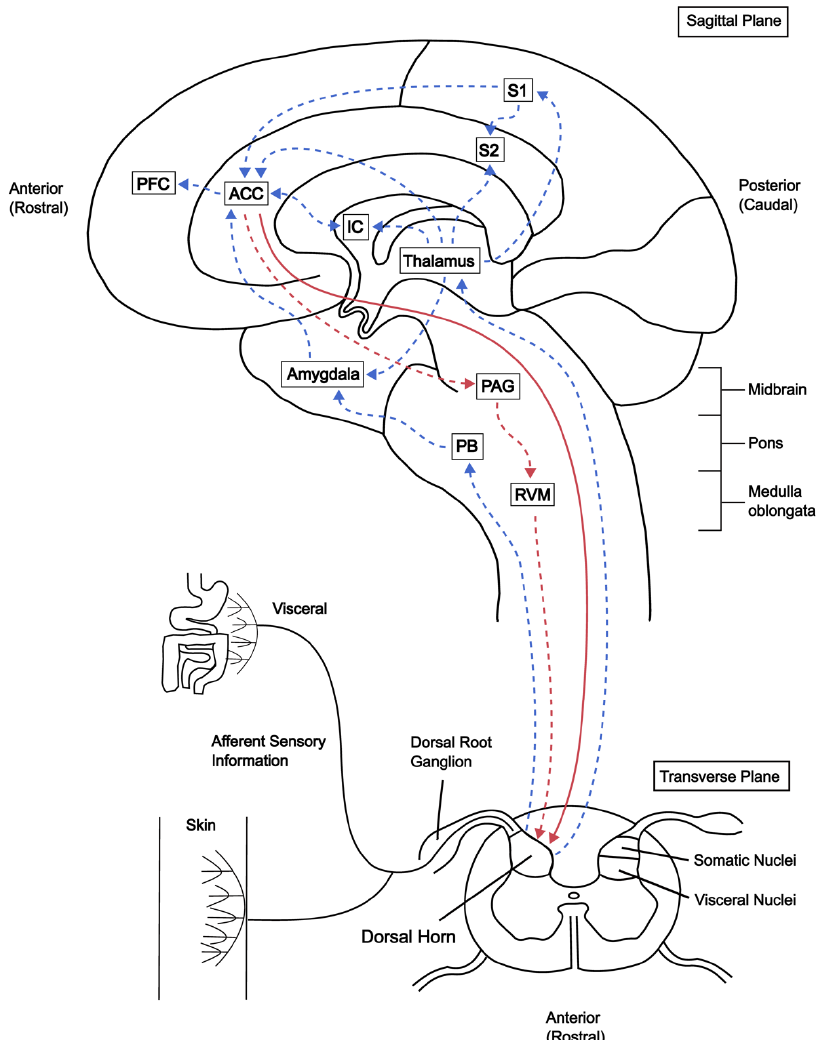
Figure 1. Top–down corticospinal pain and emotion network model. Afferent sensory neurons carry information towards the dorsal root ganglion followed by the somatic and visceral nuclei in the dorsal horn. These sensory neurons project directly to the thalamus but also indirectly to the ACC via the parabrachial nuclei (PB) and amygdala. Conversely, the ACC can modulate spinal dorsal horn neurons both directly or indirectly via the periaqueductal grey (PAG) and rostral ventromedial medulla (RVM). Direct transmission is mediated by glutamate, while indirect pathways involve ser- otonin (5-HT), which produces facilitatory effects on nociceptive transmission. Artificial stimulation of excitatory ACC neurons can enhance nociception, but activation of inhibitory interneurons pro- duces an analgesic effect suggesting the importance of E/I balance. Beyond this, the ACC also is believed to integrate pain-related sensory and emotional information and relay it to the prefrontal cortex (PFC). Blue arrows indicate ascending projections from the dorsal horn to higher brain struc- tures. Dashed red arrows and the solid red arrow indicate the indirect and direct descending path- way from the ACC to the dorsal horn, respectively. Abbreviations: PFC, prefrontal cortex; ACC,